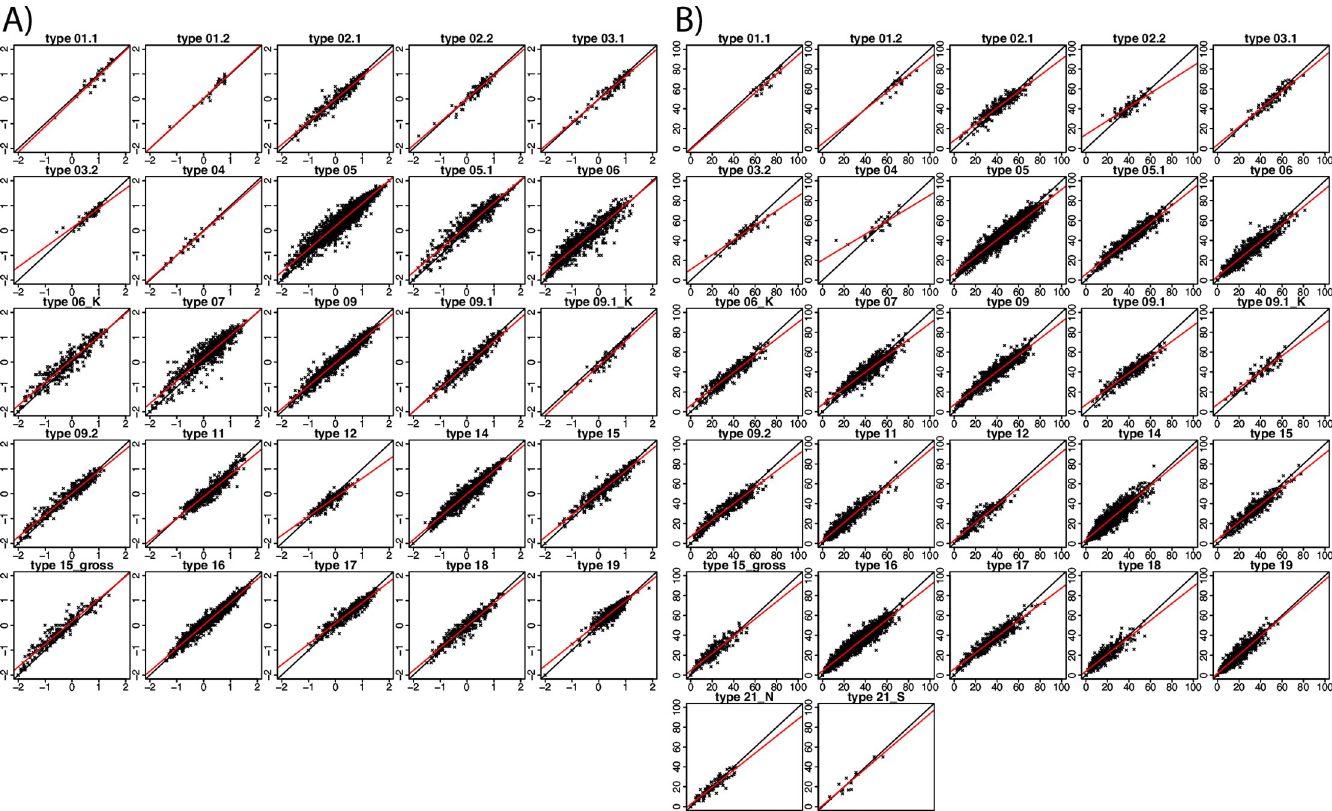
Fig 5. Regression analysis of presence/absence ( y -axis) and abundance-based data ( x -axis) for two metrics of the general degradation module: A) German fauna index, B) EPT[%].